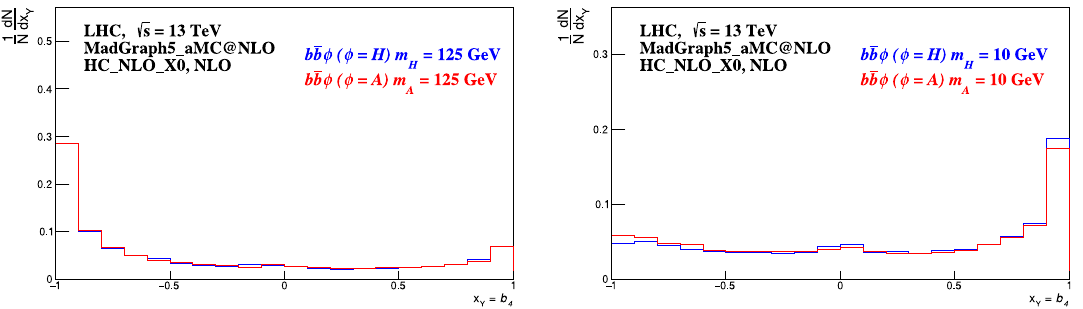
Figure 2. Parton level b 4 distributions at Next-to-leading order (NLO), normalized to unity, for m (cid:30) = 125 GeV (left) and m (cid:30) = 10 GeV